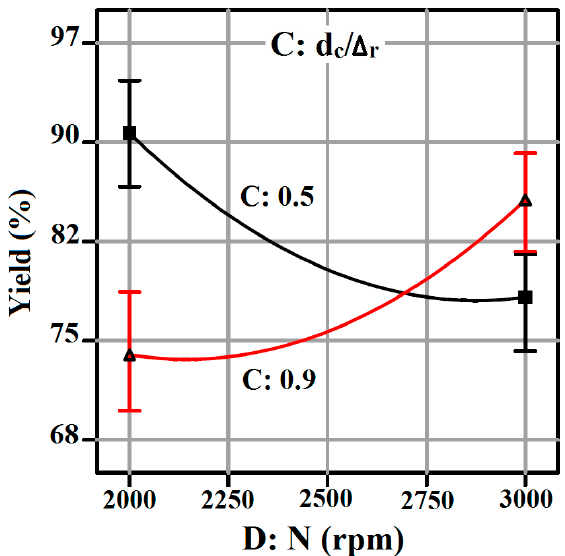
Figure 7. Interaction of rotational speed of rotor ( N ) and ratio of cavity depth to the interval of rotor-stator ( dc/ ∆ r ) on the biodiesel yield.